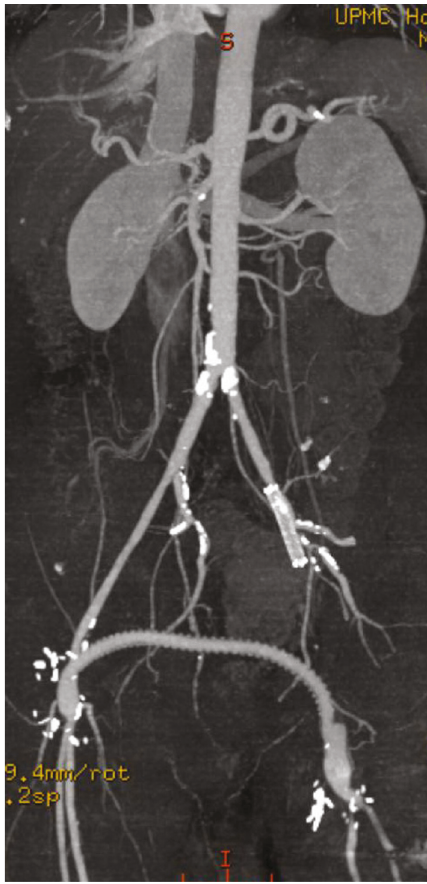
Figure 3: Postoperative CT angiogram of obturator